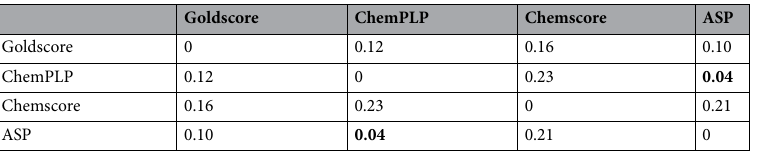
Table 1. RMSD between poses results of the scoring functions applied in the GOLD program to LaGp3. Values highlighted in bold text are the best value of RMSD from the pose results between the score functions